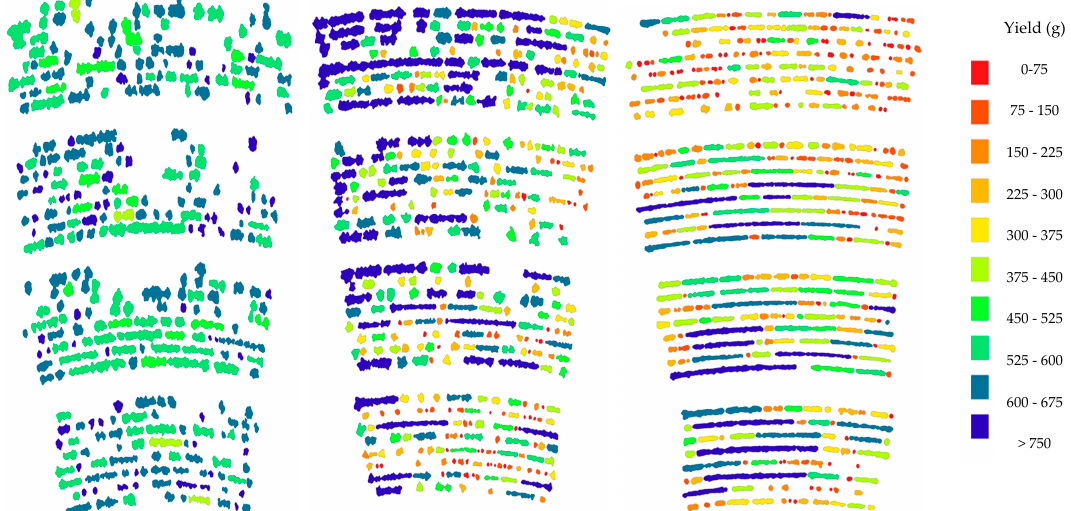
Figure 4. Binary large object (BLOB) image of plots 1, 2, and 3 with the yield (g/BLOB) mapped as BLOB color. The same symbology is assigned to all three plots. Agriculture 2020 , 11 , x FOR PEER REVIEW